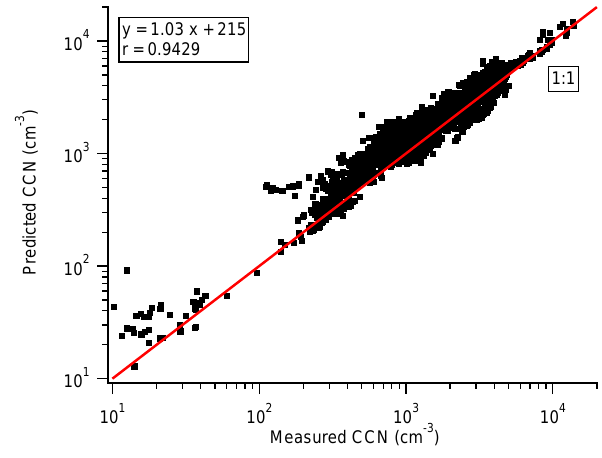
Fig. 2. Comparing predicted and measured CCN concentrations for the entire study assuming that κ ox =0.22. The red line is the 1:1